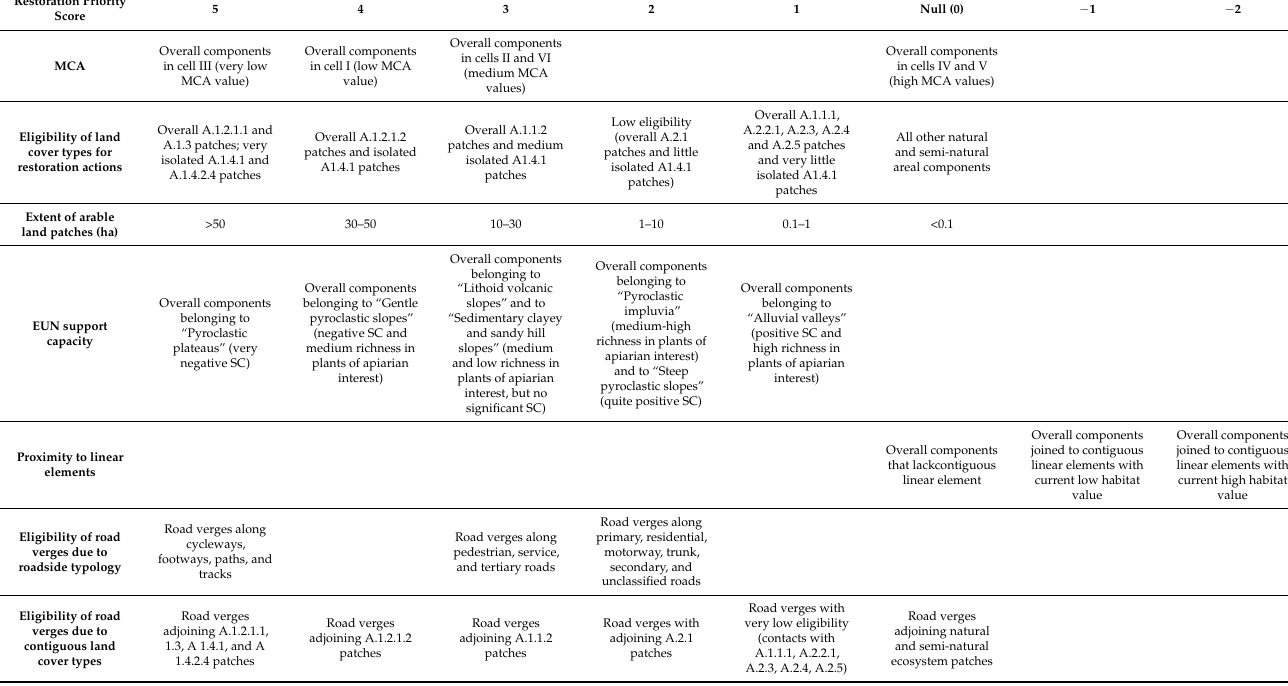
Table 7. Restoration priority scores assigned to GI components (individual ecosystem patches and individual linear elements) according to the selected